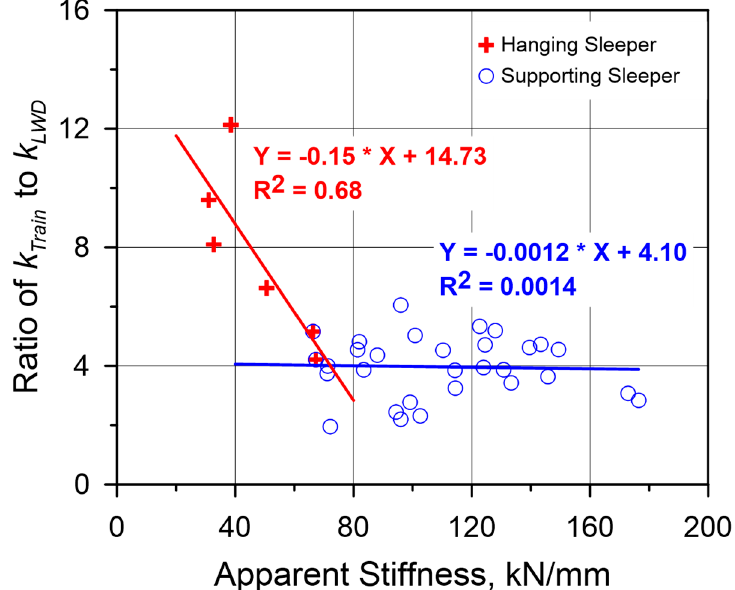
Figure 2. Change in the ratio of k Train to k LWD according to level of apparent stiffness.